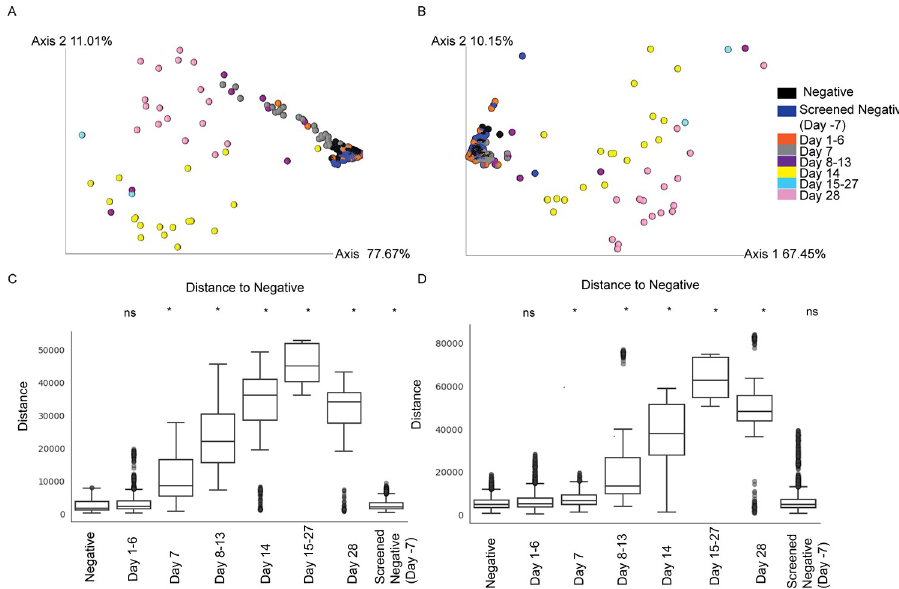
Fig 3. Principal Component Analysis (PCA) and group significance plots of antigen reactive IgM and IgG. Principle Component Analyses (PCA) were performed using Euclidean distance matrices, which were based upon average median fluorescence intensity of all antigens (MFI) independently for IgM (A) and IgG (B) antibodies. The first two principal components were used to plot individual sera in both cases. Permutational multivariate analysis of variance (PERMANOVA) illustrates pairwise distances within and between groups for IgM (C) and IgG (D). “ns” = not significant, � = q <